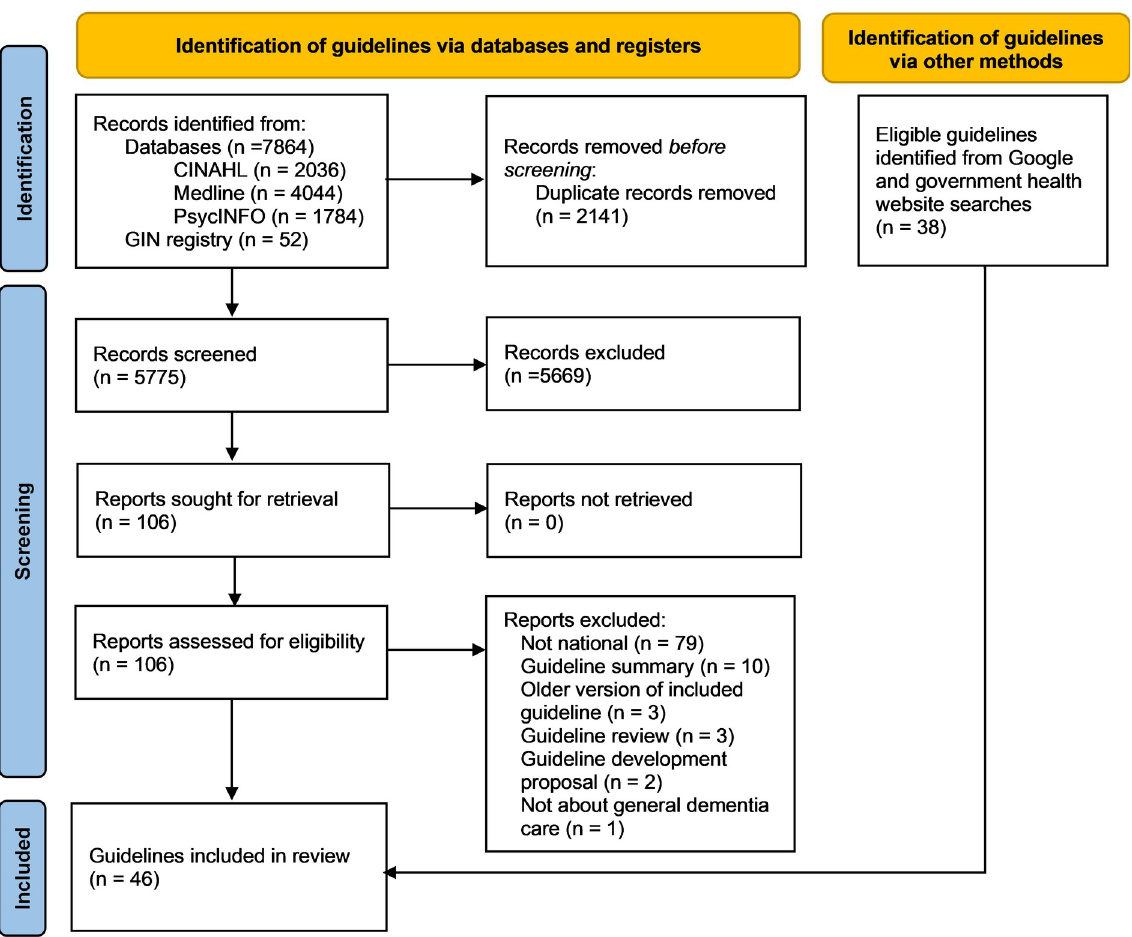
Fig 1. PRISMA flow diagram showing study selection. CINAHL, Cumulative Index to Nursing and Allied Health Literature; GIN, Guidelines International Network.